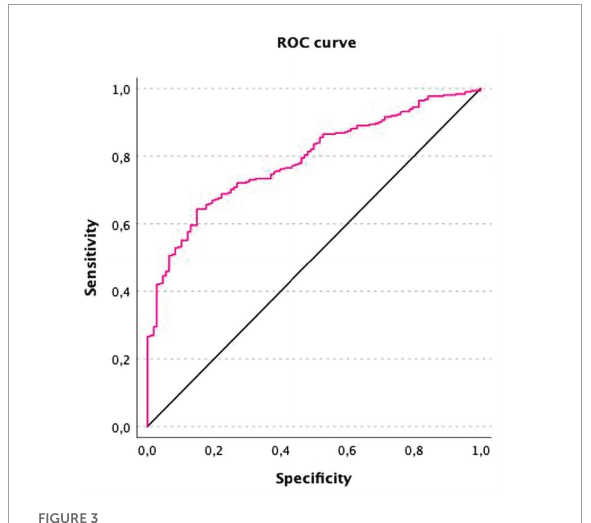
FIGURE3 Receiver operating characteristic (ROC) curve for discrimination between PCC and controls based on MoCA, digit symbol, and phonetic fluency. The model’s total diagnostic accuracy is summarized by the AUROC. A value of 0 represents a completely inaccurate test, and a value of 1 represents a completely accurate test. AUC = 0.788 (95% CI: